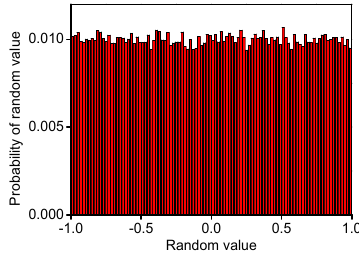
Figure 3. Random values with uniform distribution in the range of [ − 1, 1].